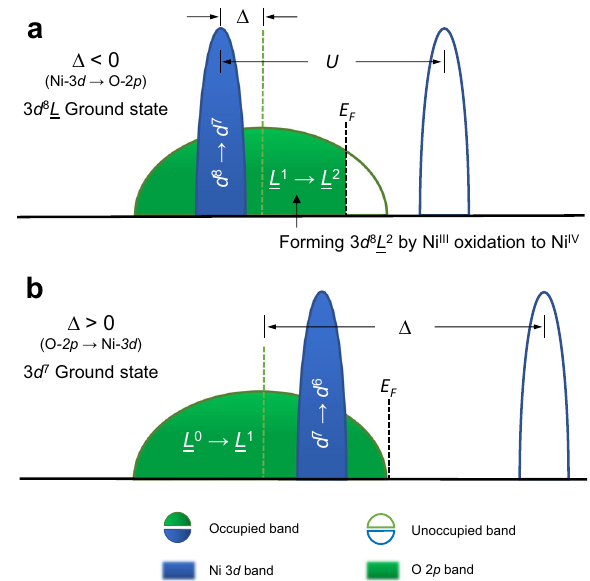
Fig. 1 | Schematic single-electron removal spectra of Ni III oxides with a formal 3 d 7 fi lling. a Δ <0 and b Δ >0 scenarios. Charge-transfer energy Δ : energy cost for electron transferring from the O 2 p band to the Ni 3 d band, and U : energy cost for electron transferring from the occupied 3 d band to the unoccupie d 3 d band. The hybridization between Ni 3 d and O 2 p is neglecte d for sim p licity. The Fermi level (E F ) is shown as a vertical dash black line and the O 2 p band is used as the energy reference considering the position of E F is arbitrary in the band